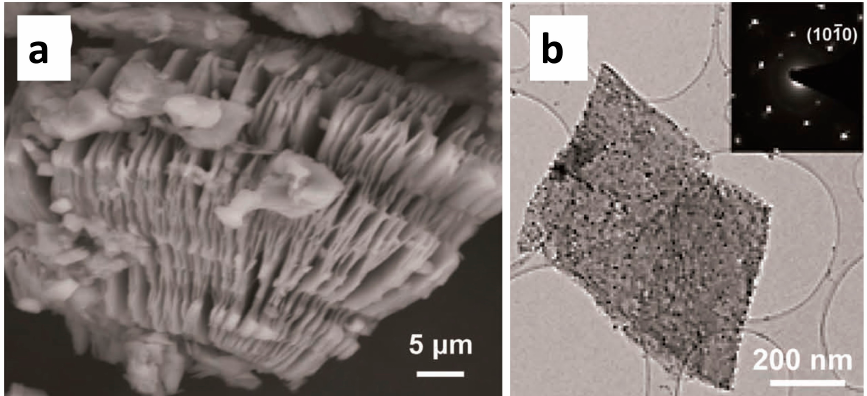
Figure 1. ( a ) SEM image of multi-layered Ti 3 C 2 T x MXene. ( b ) TEM image of delaminated Ti 3 C 2 T x MXene nanosheets; reproduced from [1], with the permission of